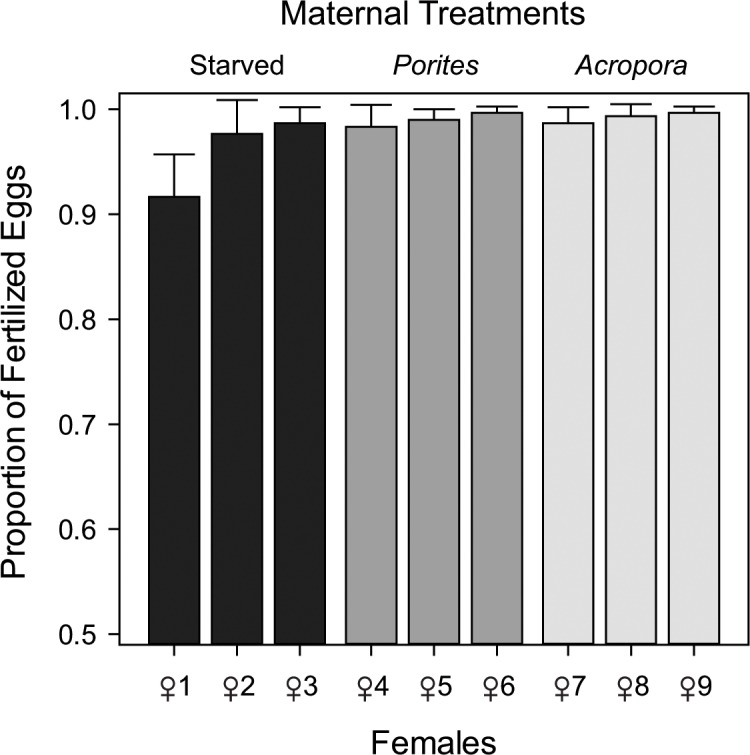
Fertilization success across all females under each maternal nutrition treatment.Proportion of fertilized eggs calculated from the number of eggs with raised fertilization envelopes out of 100 randomly selected eggs (n = 3). Error bars represent +1 standard deviation (SD).